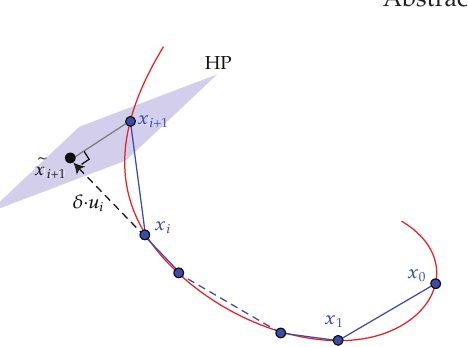
Figure 2: Sketch of one step in pseudo-arclength continuation